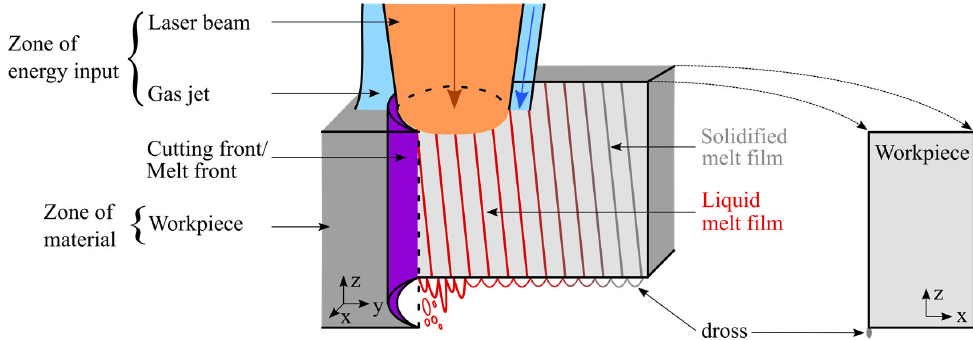
Figure 1. Schematic illustration of the laser cutting process highlighting the important zones: zone of energy input (laser beam and gas jet), zone of the material and cutting front (violet) and melt film (red) acc. to [5].